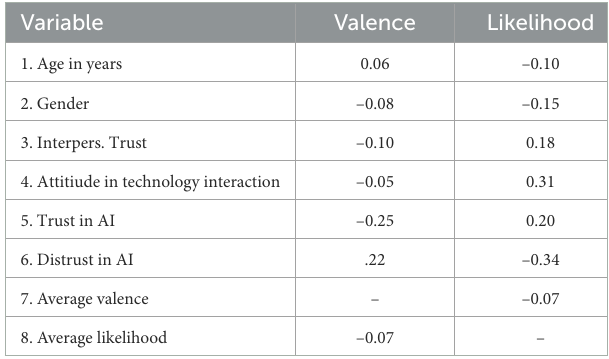
TABLE 3 Correlations between AI assessment and the (explanatory) user